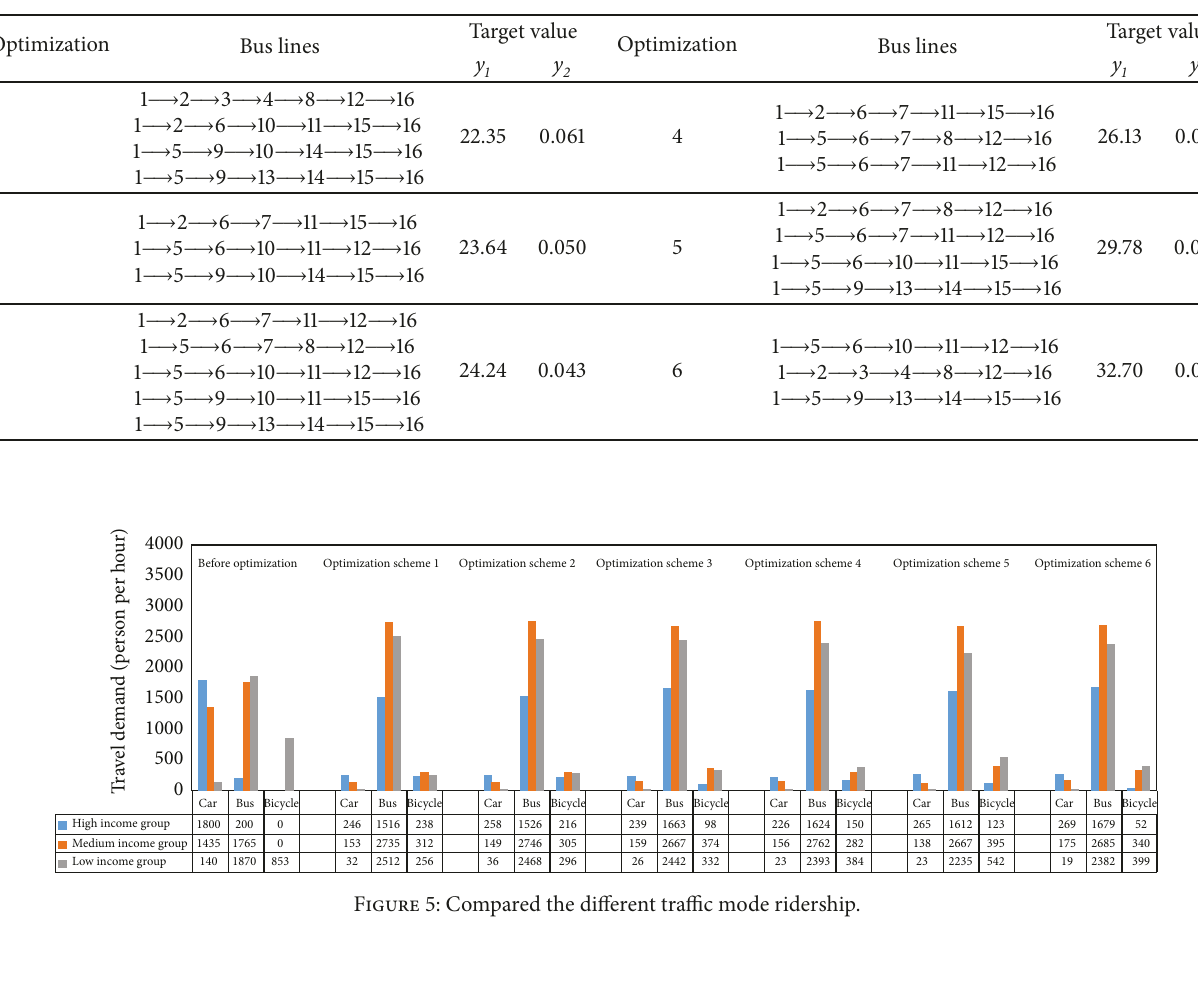
Table 4: Calculation results.